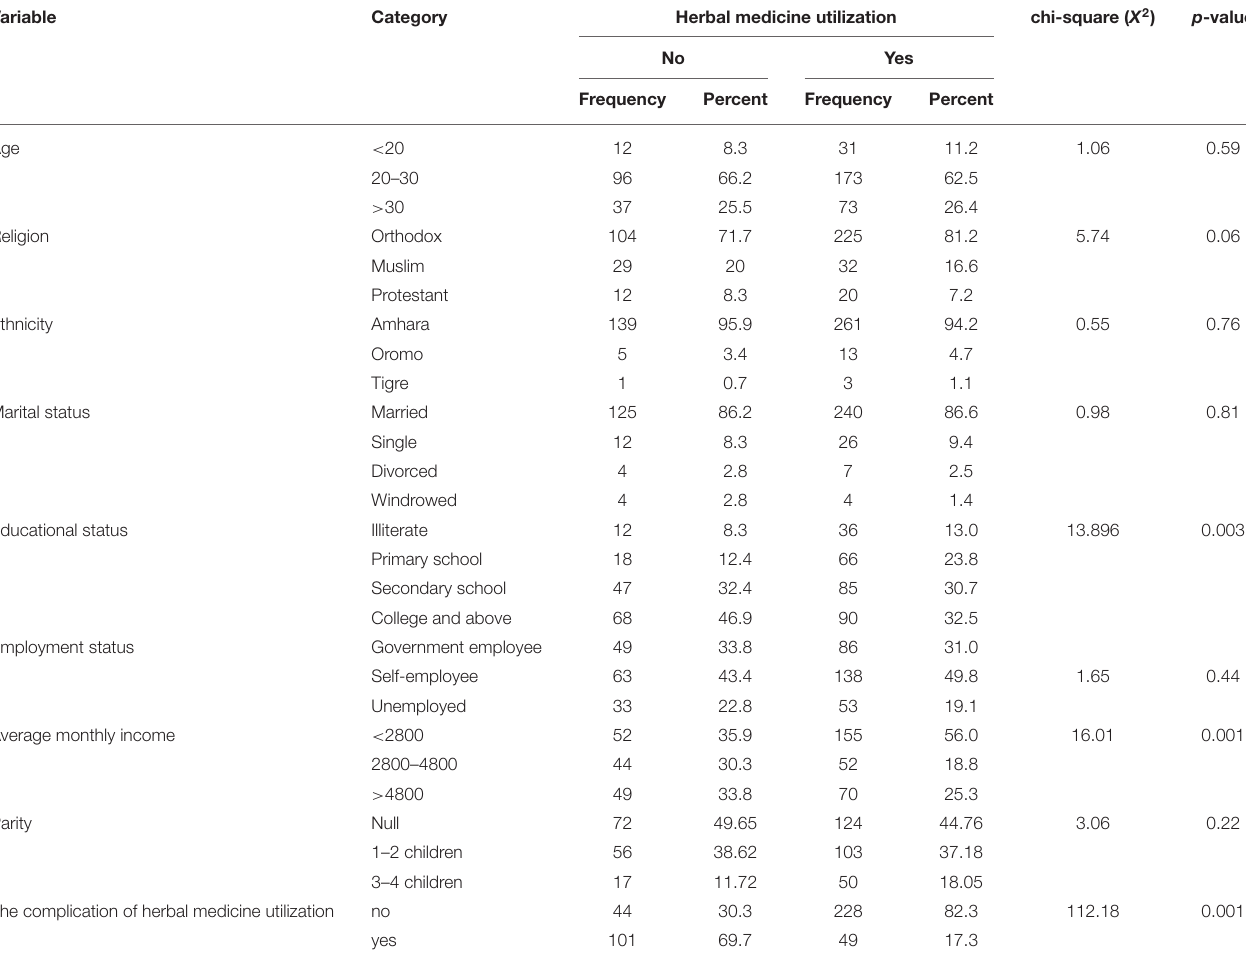
TABLE 1 | Distribution of study participants by sociodemographic characteristics and their respective chi-square test at public health institutions in Debre Berhan town, Ethiopia, 2021 ( n = 422).